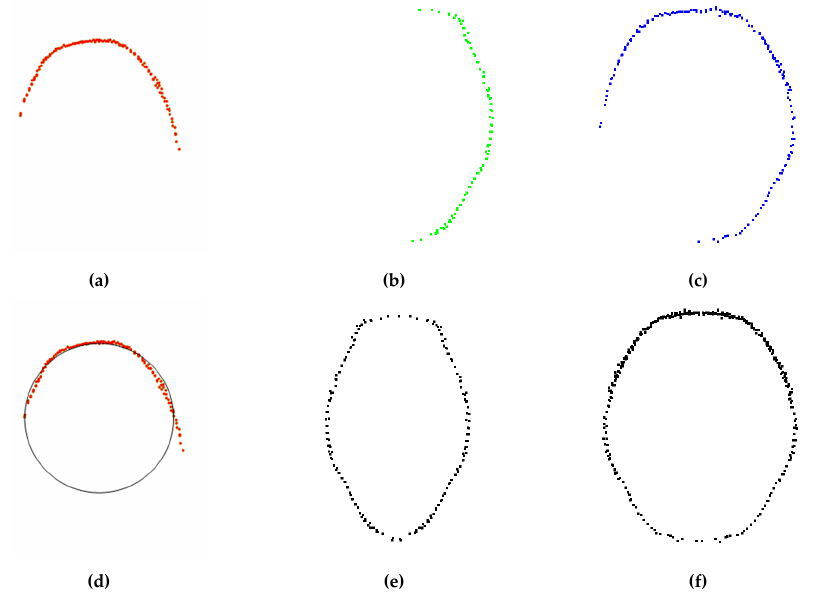
Figure 6. The first line is the heart girth point cloud obtained by different data acquisition ways. The second line is the complete heart girth point cloud obtained by different data acquisition ways. ( a ) Pig heart girth point clouds obtained by a top-view Kinect sensor ; ( b ) Pig heart girth point cloud obtained by a side-view Kinect sensor ; ( c ) Pig heart girth point cloud obtained by two-view Kinect sensors; ( d ) Fitting heart girth point cloud based on top-view point cloud; ( e ) Pig heart girth point cloud obtained by mirror symmetry based on side-view point cloud; ( f ) Pig heart girth point cloud obtained by mirror symmetry based on two - view point cloud. Table 1. Pig heart girth measurement results obtain by different data acquisition ways.